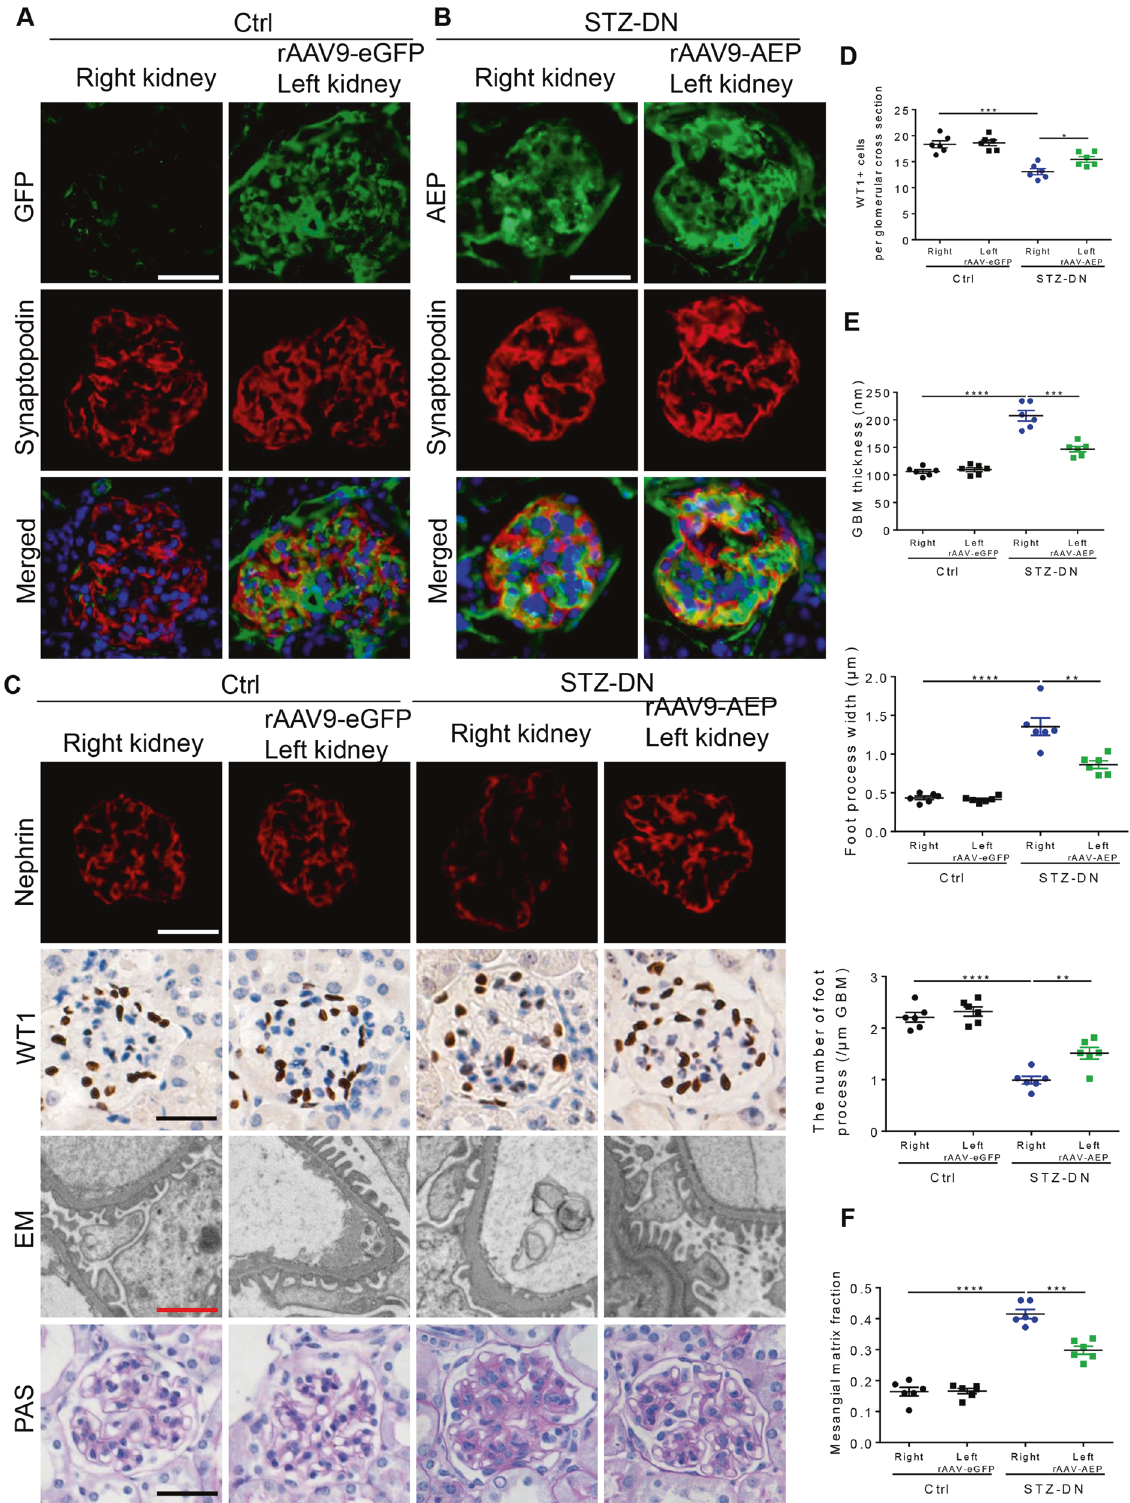
in Fig. 4G, H, AEP upregulation reversed the HG-induced podocyte cytoskeleton disarrangement. In addition, Desmin and active Caspase 3 expression signi fi cantly decreased with AEP transfection (Fig. 4I, J). Similar F-actin and cell injury reversion was observed in TGF- β 1-stimulated cells (Fig. S7C – F). These in vitro data suggest